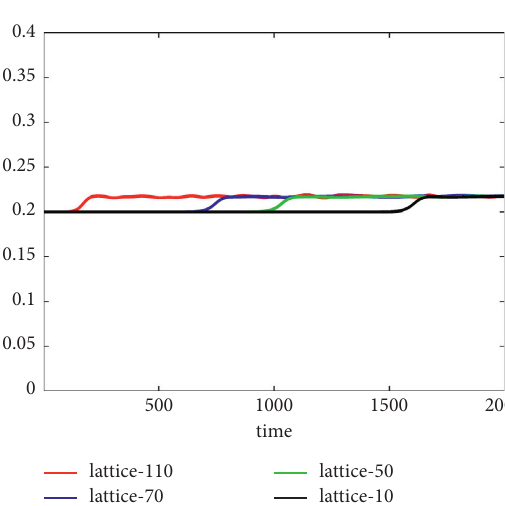
Figure 7: Density evolution diagram.